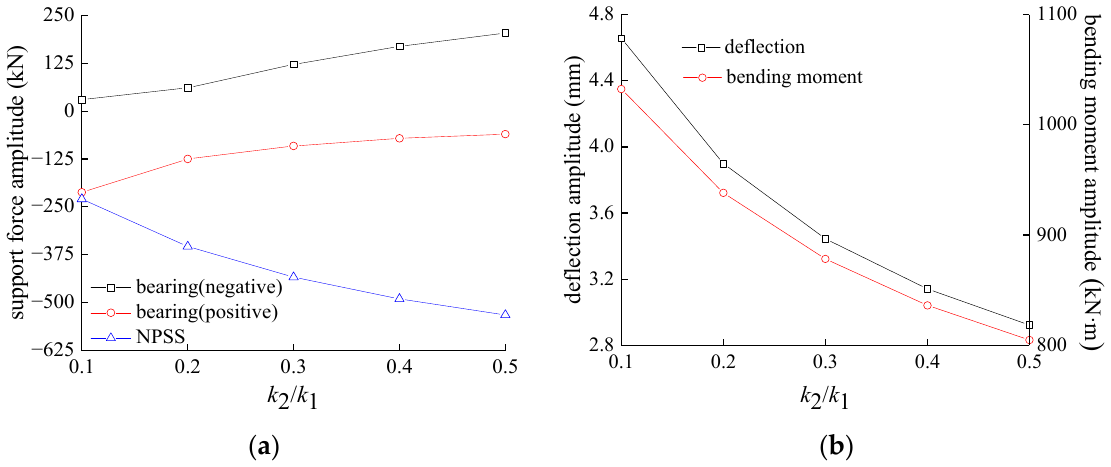
Figure 14. Effects of the support stiffness. ( a ) Support force; ( b ) deflection and bending moment amplitudes.